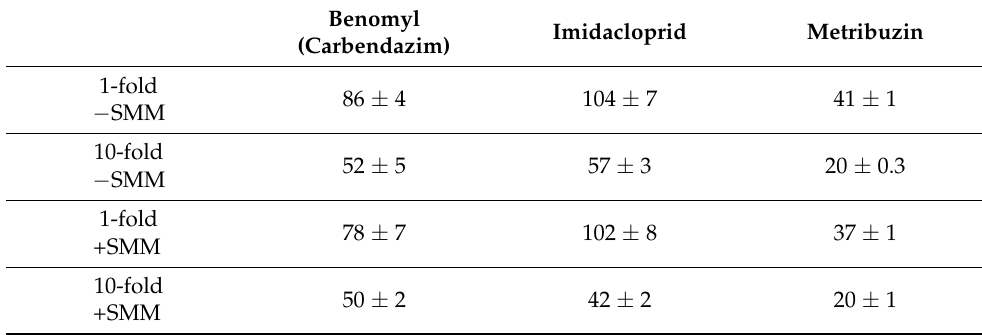
Table 4. Half-life (t 1/2) of active substances with standard deviation, day ( n = 3).